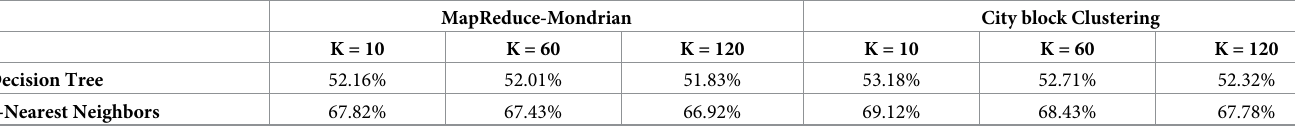
Table 5. Accuracy criterion on the anonymous poker hand for λ = 4, k´ = 3 and different values of k.